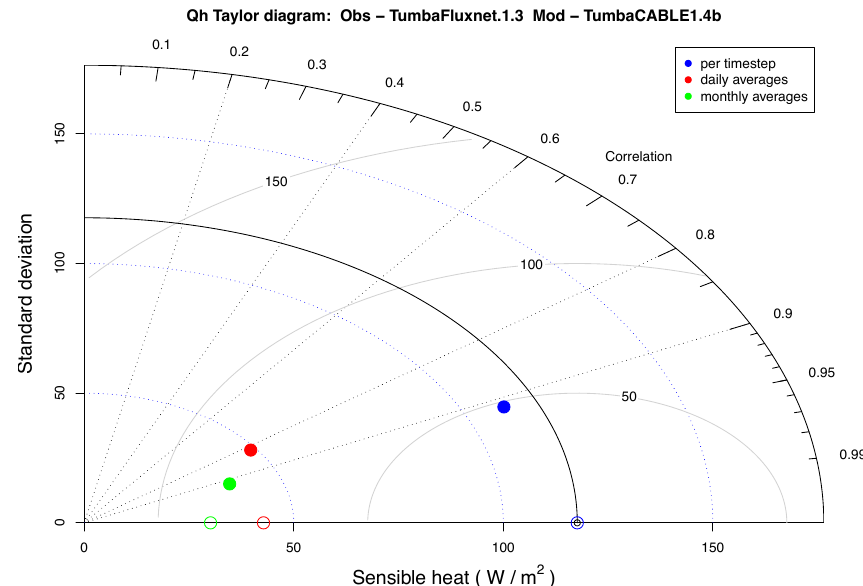
Fig. 4. Taylor diagram of sensible heat flux at a single flux tower site. Per-timestep standard deviation, correlation with observations and root mean square error are shown in blue; daily values in red; and monthly values in